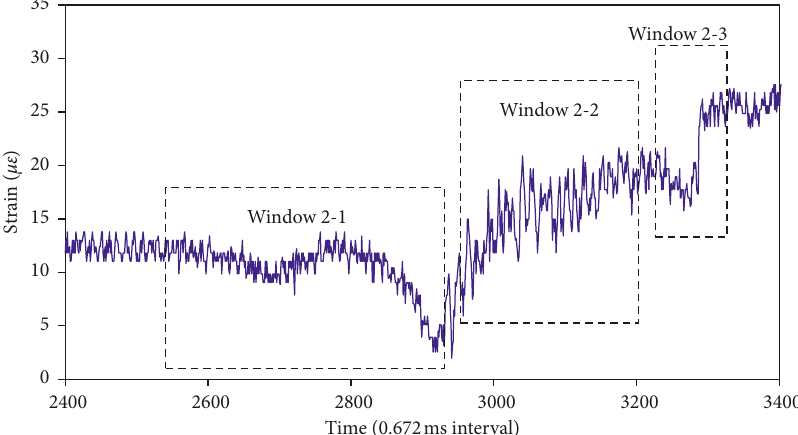
Figure 17: Partial enlarged